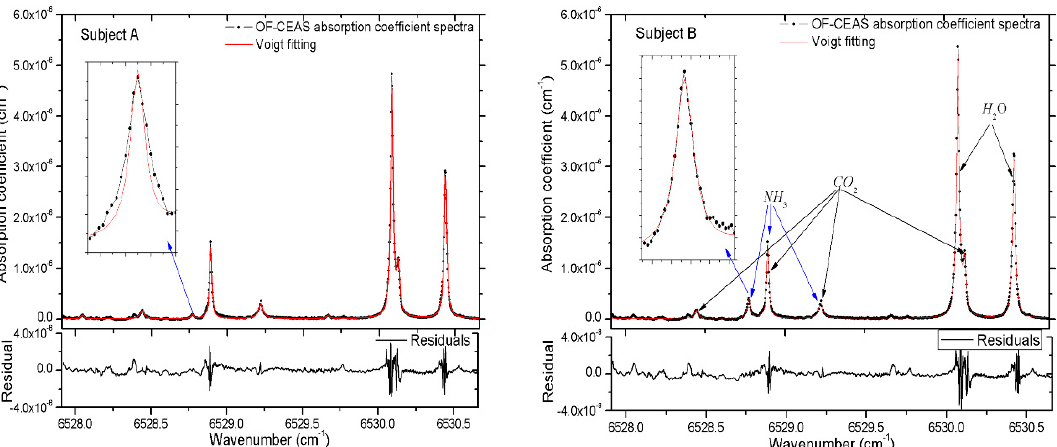
Figure 4. Absorption spectra of exhaled breath samples of two subjects. Subject A for a healthy adult aged 26, subject B for a 25 years old man suffering from Helicobacter pylori infection. The laser frequency is scanned over the range 6527.91–6530.66 cm − 1 . The absorption coefficient spectra is converted from the cavity transmission signals using Equation 3 in a single scan. The black dots represent a single laser scan achieved in 5 s, and the red line shows the Voigt fitting of all absorption lines including NH 3 , H 2 O and CO 2 . Below the spectra is the residuals to the fitting. The 1 σ standard deviation of the residuals yields a minimum detectable absorption coefficient of α min = 2.3 × 10 − 9 cm − 1 for a single scan within 5 s.